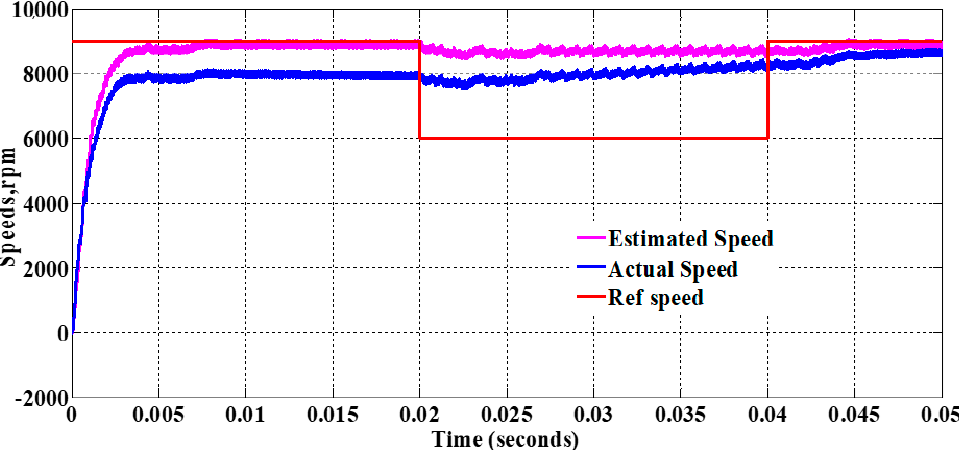
Figure 18. Estimated and actual speeds.